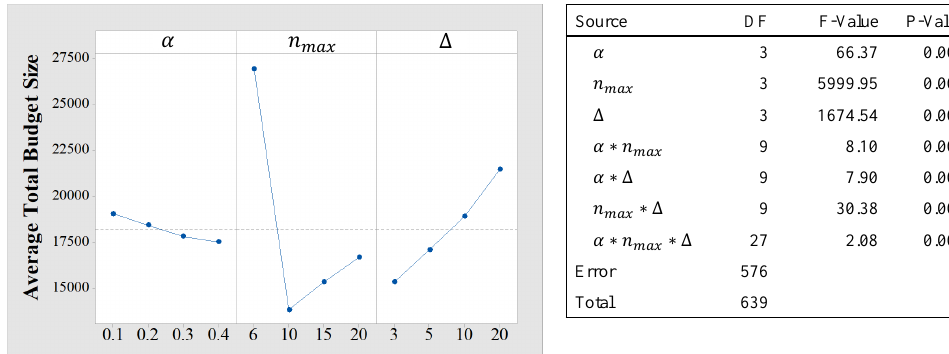
Figure 3. The main effect plot and the ANOVA table. A total of 500 replications are executed and divided into 10 batches. The Box–Cox transformation is performed, and R 2